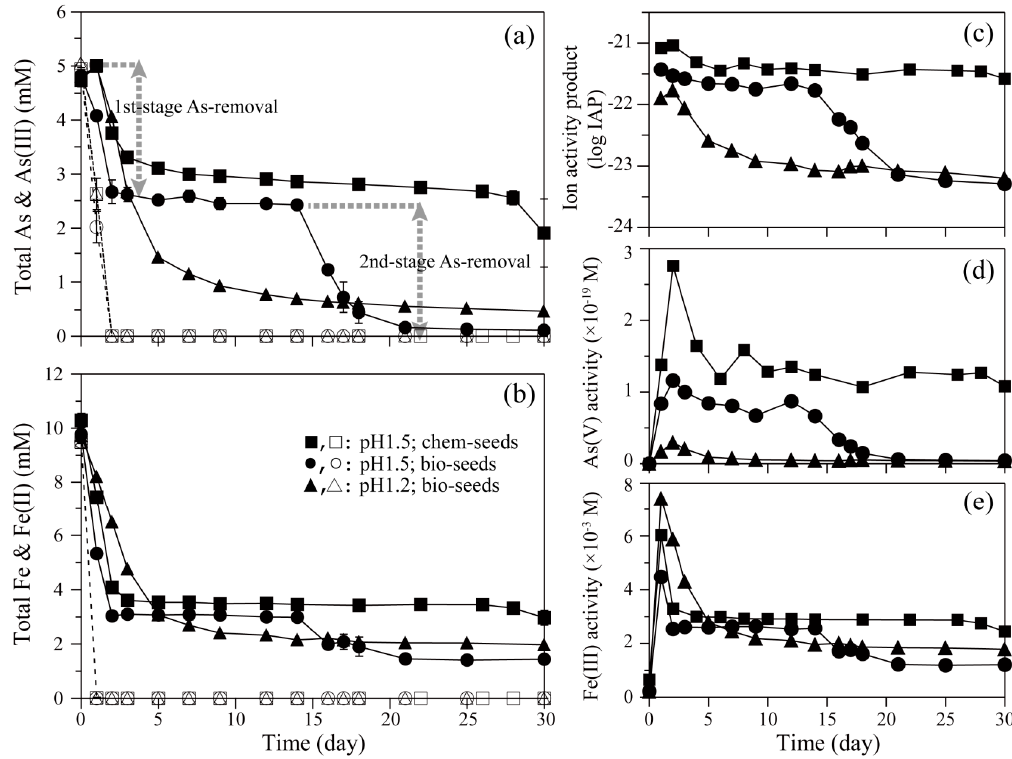
Figure 3. Bioscorodite crystallization test by feeding different seed crystals at pH 1.5 or pH 1.2: Bio- (pH 1.5; ● ○ /pH 1.2; ▲ ∆ ) or chemical- (pH 1.5; ■ □ ) scorodite seeds were fed at 0.15%. [As(III)] ini = 4.7 mM. [Fe(II)] ini = 9.5 mM. ( a ) Concentrations of total soluble As (solid lines and filled symbols) and As(III) (broken lines and open symbols). Dotted arrows indicate the first- (day 0–2) and second-stage (day 14–21) As-removal on bioscorodite seeds at pH 1.5. ( b ) Concentrations of total soluble Fe (solid lines and filled symbols) and Fe(II) (broken lines and open symbols). ( c ) Ion activity product of bioscorodite. ( d ) As(V) ion activity. ( e ) Fe(III) ion activity.